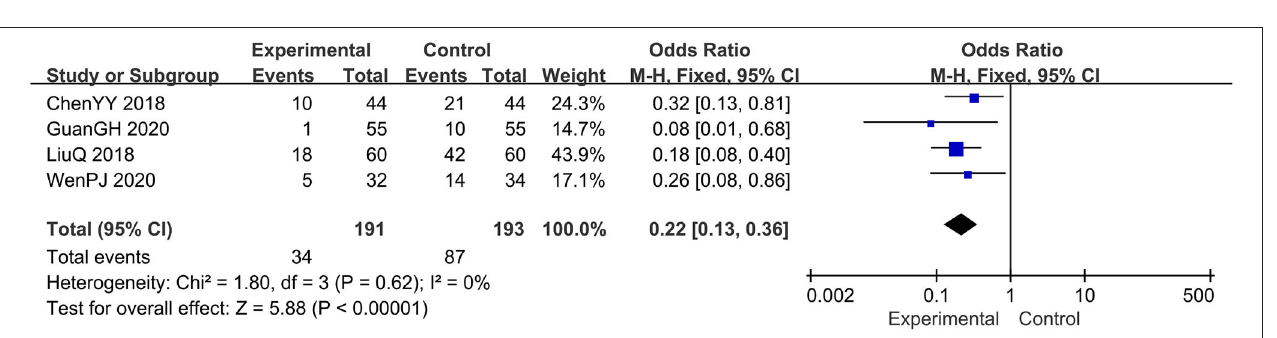
FIGURE 10 | The meta-analysis for comparison of combination therapy vs. prednisone for the recurrence